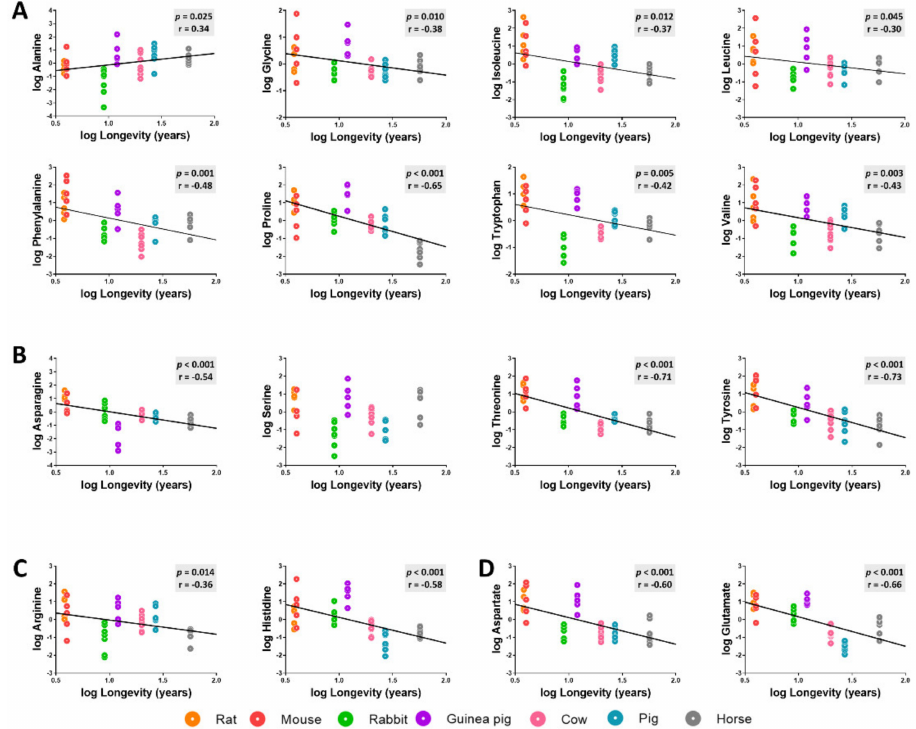
Figure 4. Heart concentrations of non-polar ( A ), polar uncharged ( B ), positively charged ( C ), and negatively charged ( D ) amino acids as a function of mammalian longevity. Individual amino acid heart concentrations are reported in log(mmol/g tissue). Pearson correlation between heart amino acids and animal longevity was performed ( A – D ). Linear regression was applied when significant relationships were found. Minimum significance level was set at p < 0.05. All amino acid values were log-transformed in order to accomplish the assumptions of normality.